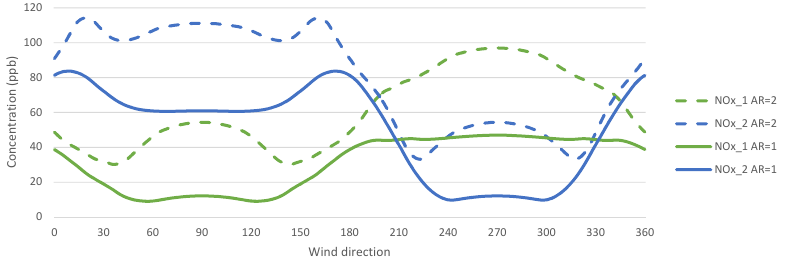
Figure 14. Theoretical calculation of the concentration of the two receptors for a street canyon with an emission inhomogeneity of 70% (north going)/30% (south going) as a function of aspect ratio (AR) and wind direction. Receptor 1 is marked in green and receptor 2 is marked in blue. The case with the high aspect ratio is marked with dotted